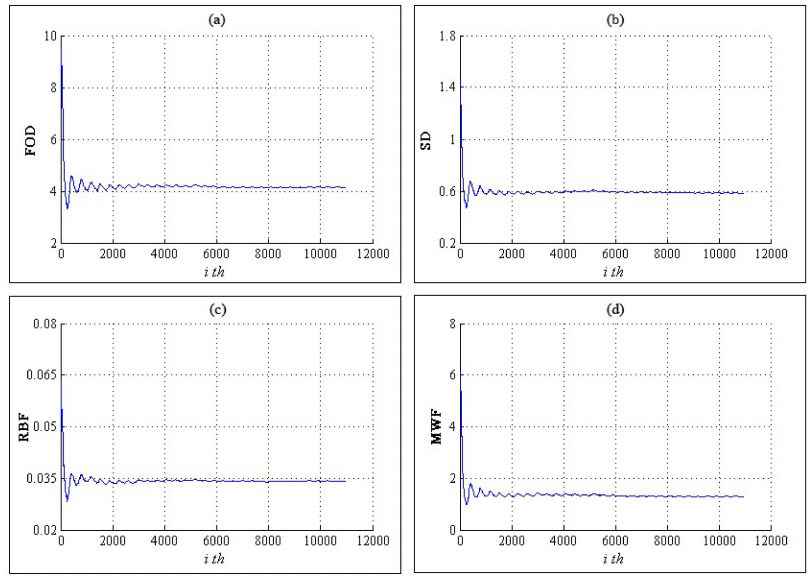
Figure 10. Comparison of indices obtained using overlay wind speed matrix. The symbol i is the column number of the overlay wind speed matrix. ( a ) the FOD index; ( b ) the SD index; ( c ) the RBF index; ( d ) the MWF index.